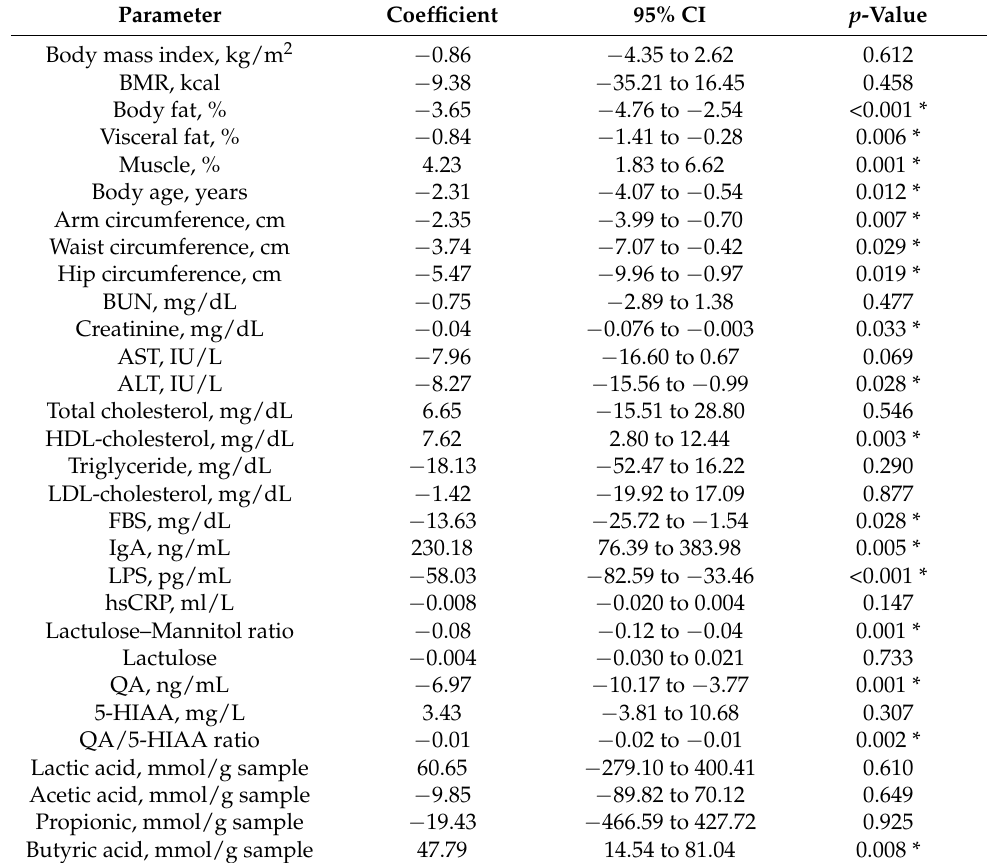
Table 4. Gaussian regression analysis summary at week 12 of treatment for probiotics group.